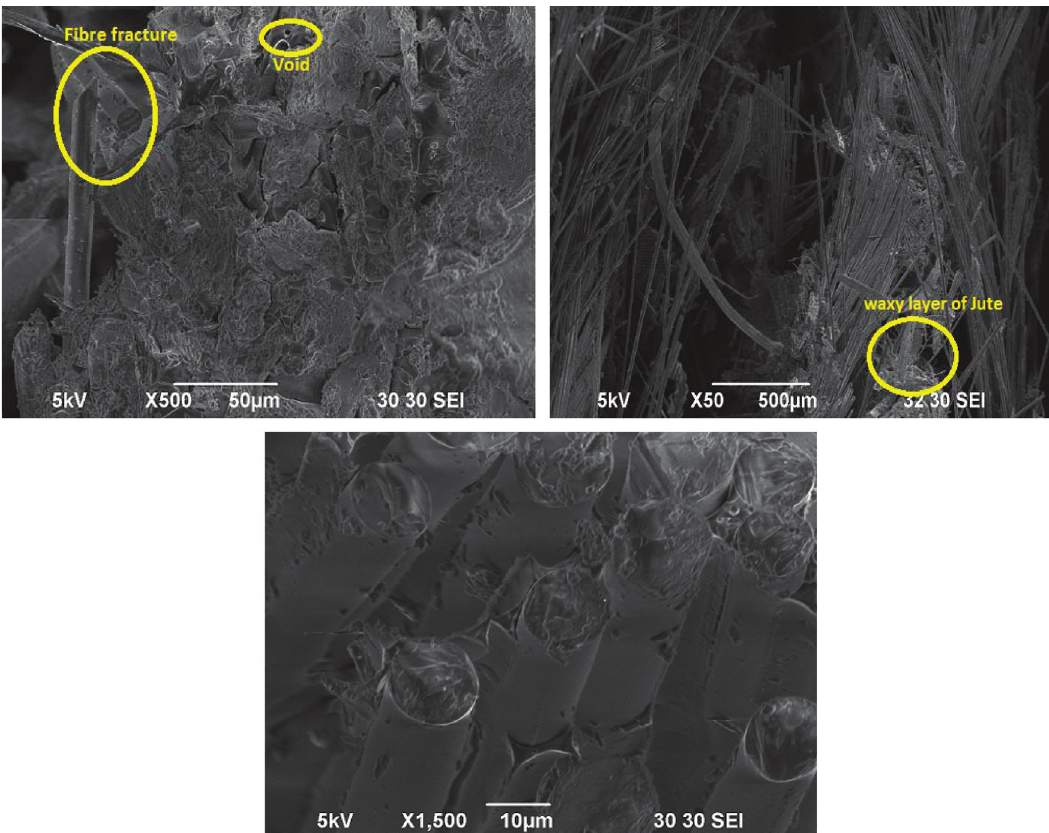
Figure 3 Fractography image of tensile strength-tested specimen.